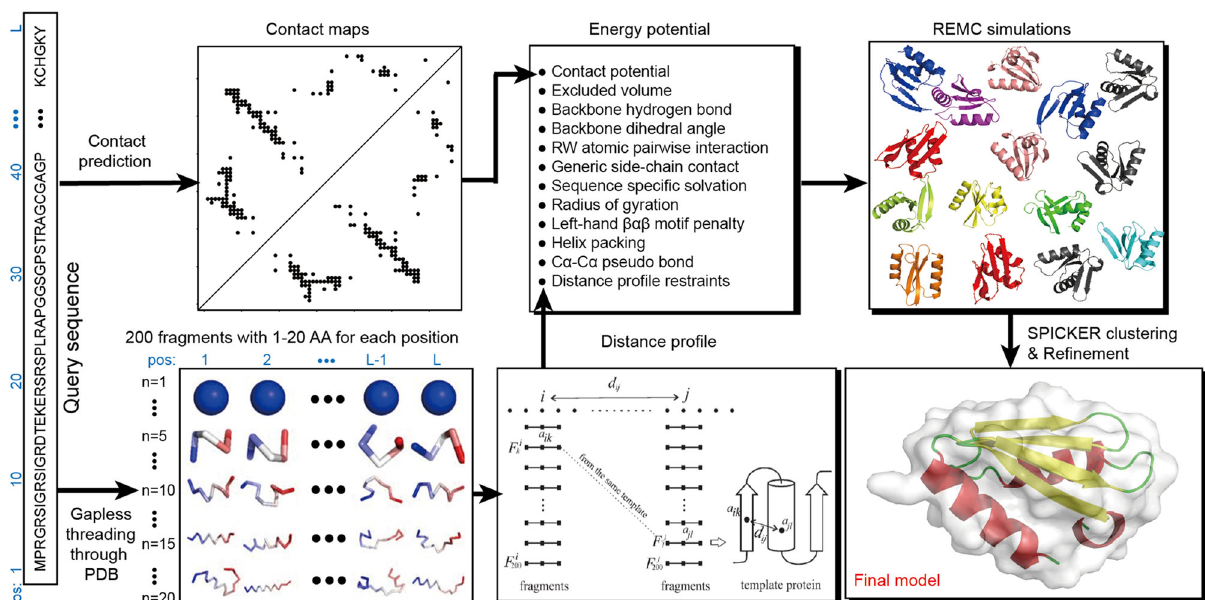
Fig. 1 Flowchart of C-QUARK for contact-guided ab initio protein structure prediction. The pipeline consists of fi ve consecutive steps: multiple sequence alignment generation by DeepMSA, deep-learning based contact-map prediction, fragment creation, contact-guided Monte Carlo folding simulation, and model selection and re fi nement.